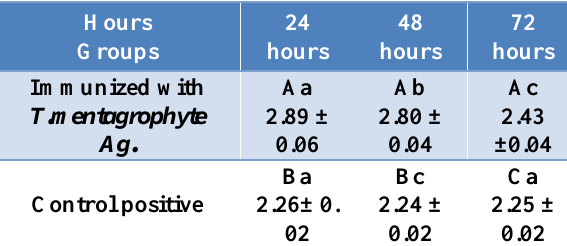
Table, 1: The mean values of skin thickness in immunized mice with T.mentagrophyte Ags (1 st group) and control(2 nd group) at 24,48 and 72hrs. After